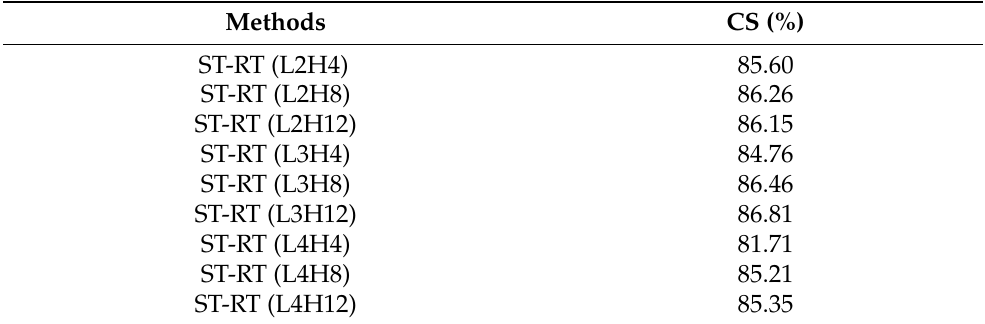
Table 7. Accuracy comparison for the ST-RT models with different sampling strategies, and their combination. “X && Y” means the fusion of the model with X sampling strategy and the model with Y sampling strategy.